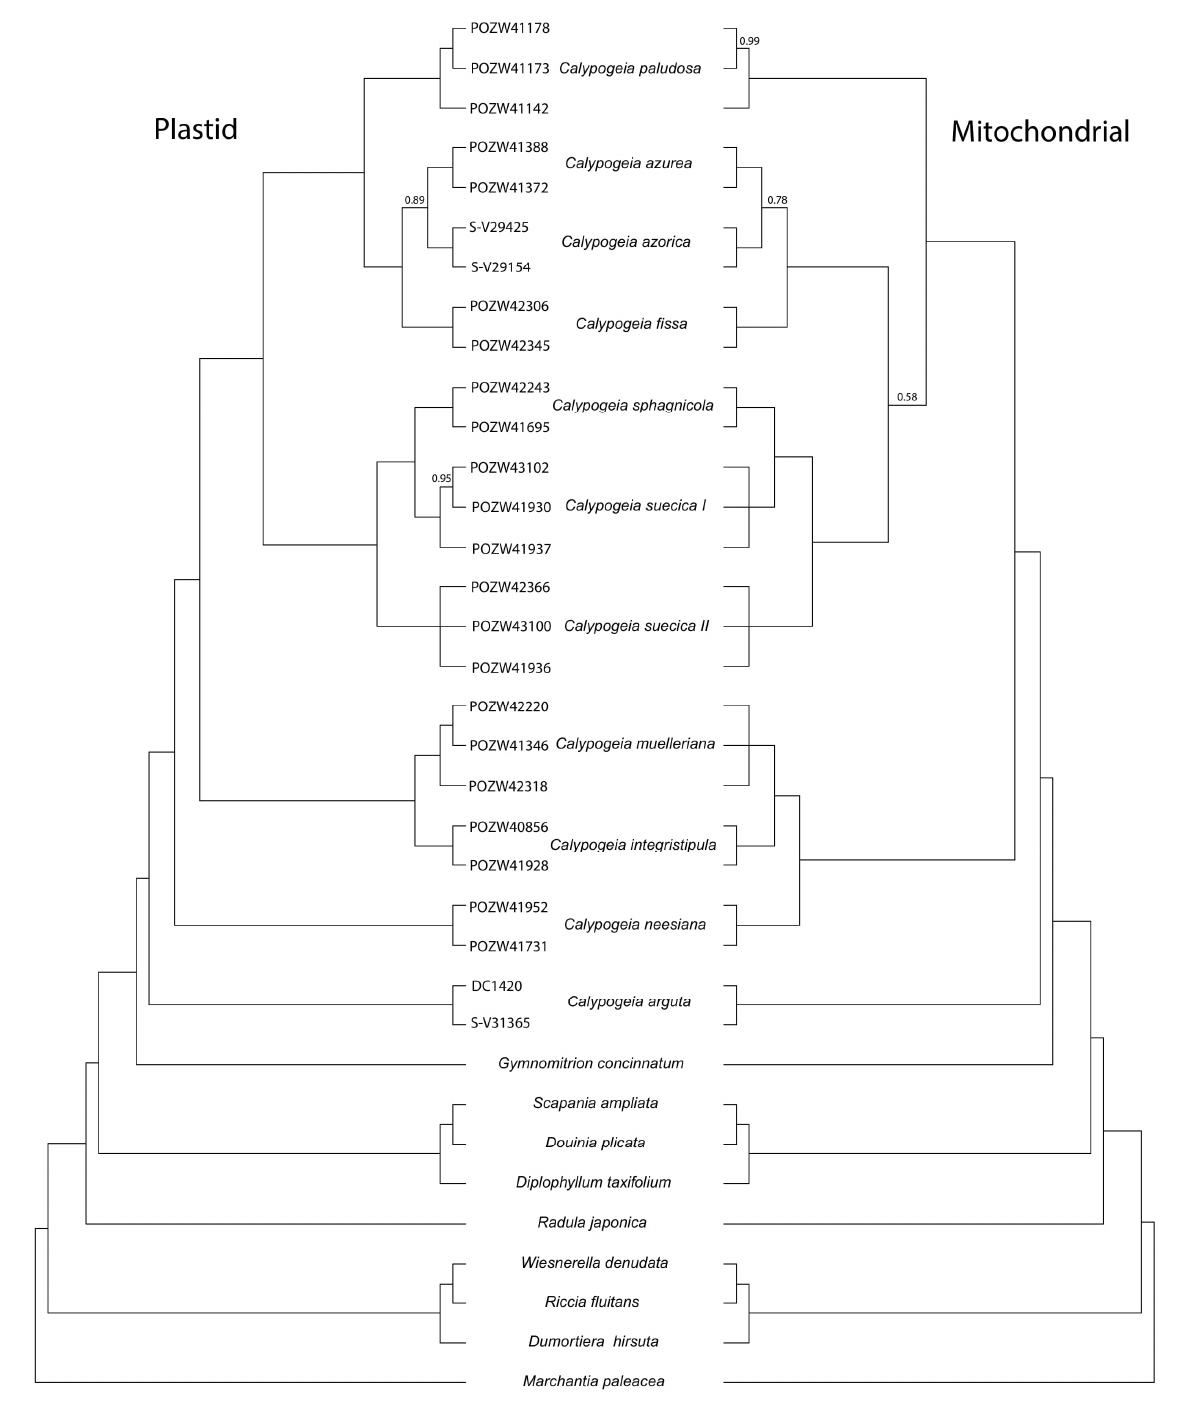
Figure 2. The phylogram based on plastid and mitochondrial CDSs derived from a Bayesian analysis. The posterior probability value lower than 1 is given at the node.